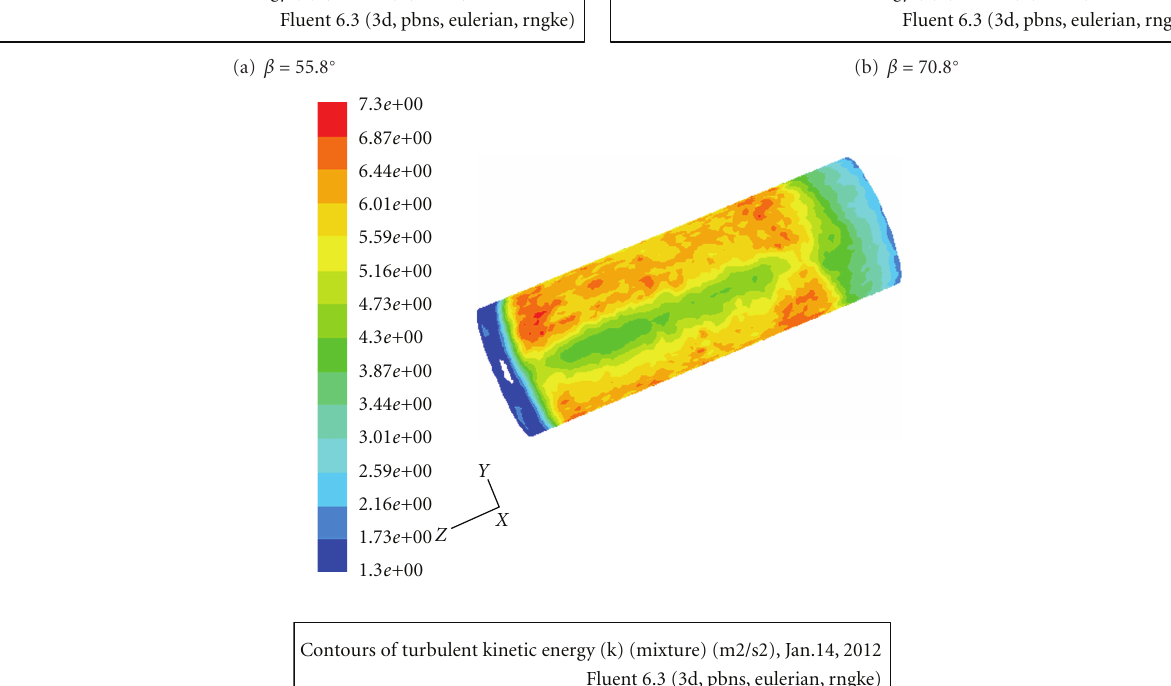
laying angle is, the shorter the gas-liquid separation field is to the blade front